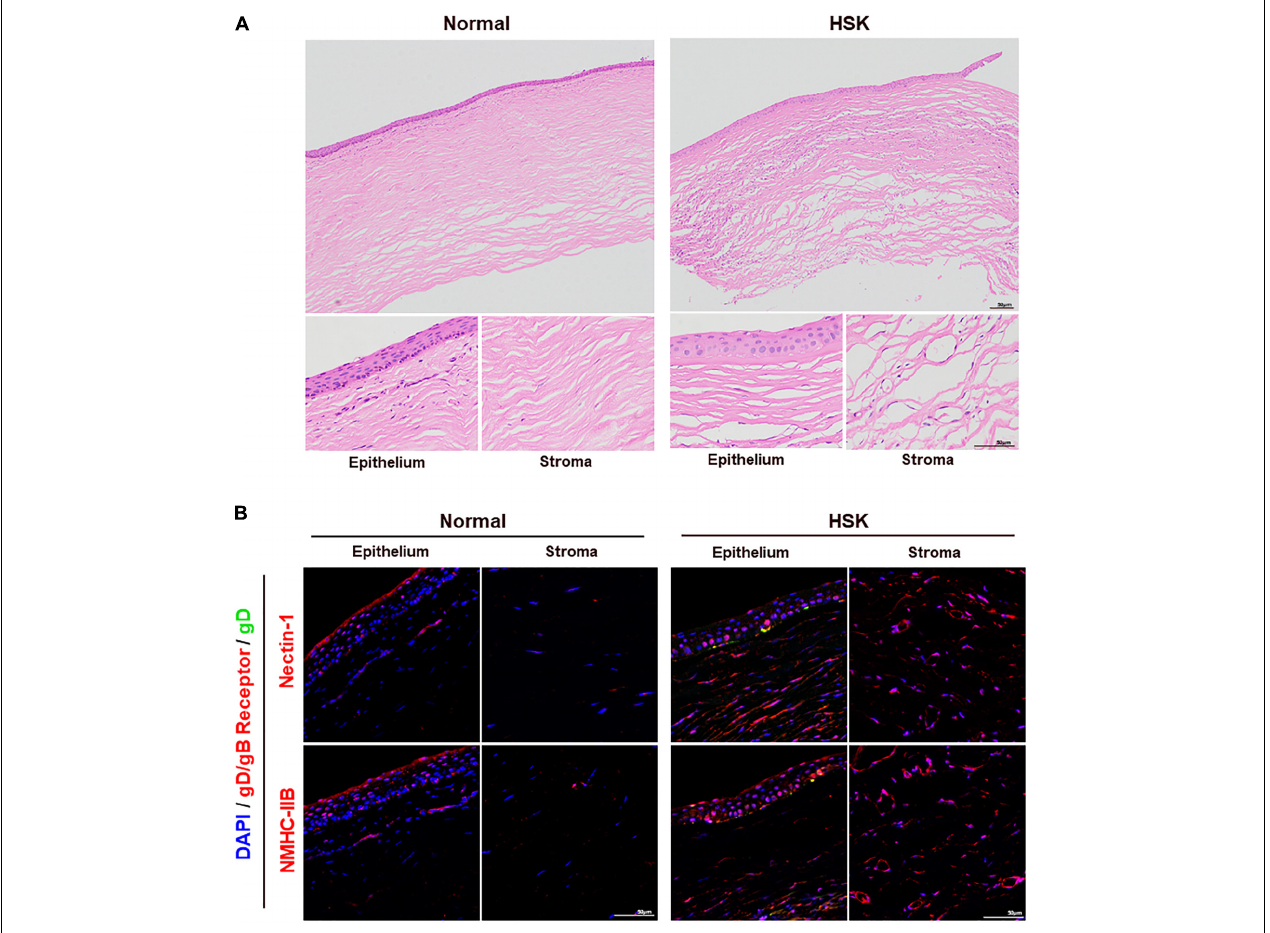
FIGURE 7 | Nectin-1 and NMHC-IIB were upregulated in the corneas of patients with HSK. (A) Shown is HE staining of corneal sections from healthy donors and patients with HSK ( n = 3). Corneas of patients with HSK presented significant corneal thickening with extensive infiltration of inflammatory cells and vascularization. (B) Shown is immunofluorescence analysis of HSV-1 gD, nectin-1, and NMHC-IIB expression and localization in corneal sections of healthy donors and patients with HSK ( n = 3). The expression of nectin-1 and NMHC-IIB was significantly increased throughout the